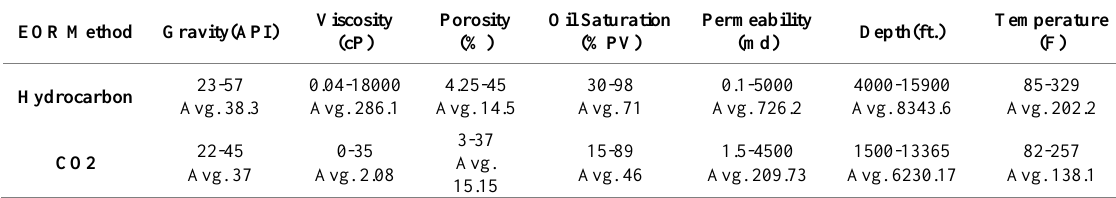
Table 1. Selected table for miscible injection of CO2 and hydrocarbon